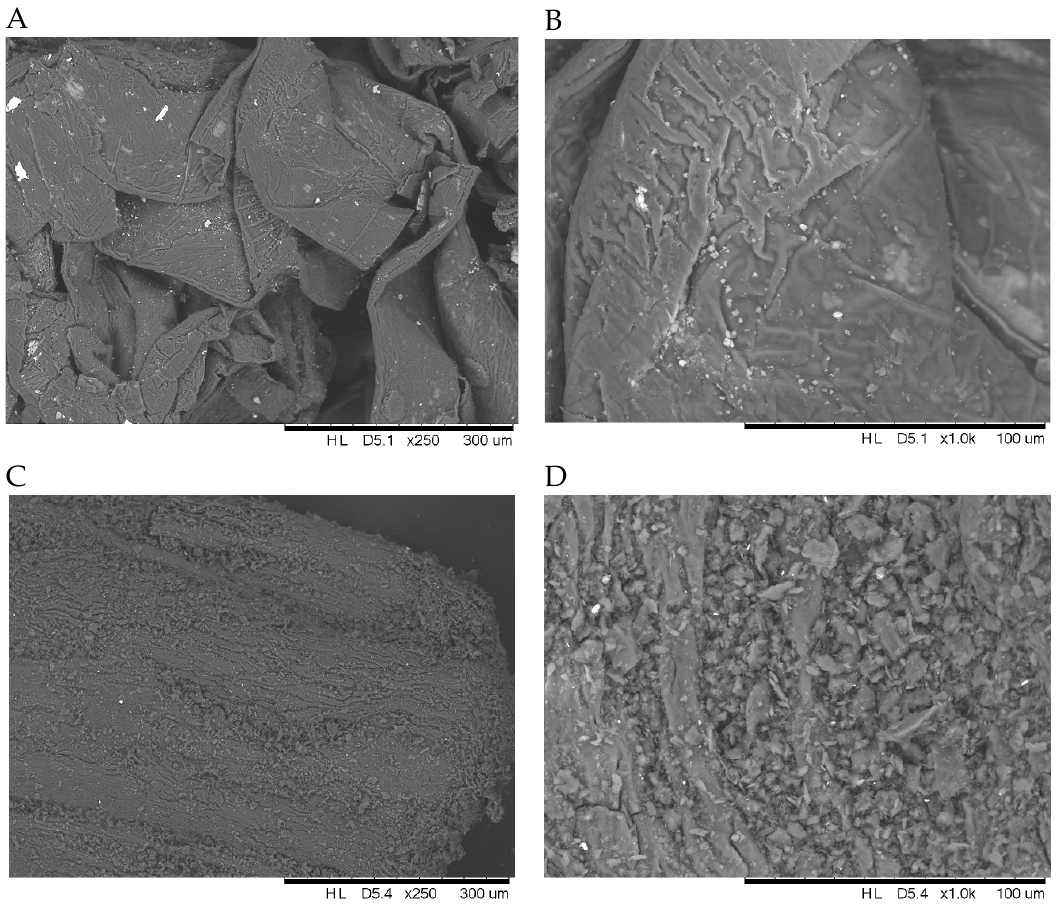
Figure 2. Scanning Electron Micrographs of the adsorbents: Chaetomorpha ( A , B ), and Sargassum sp. ( C , D ) at different magnifications.